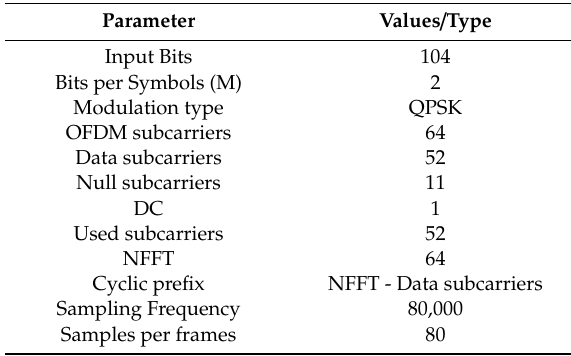
Figure 2. Simulink model. Table 3. Software parameters.